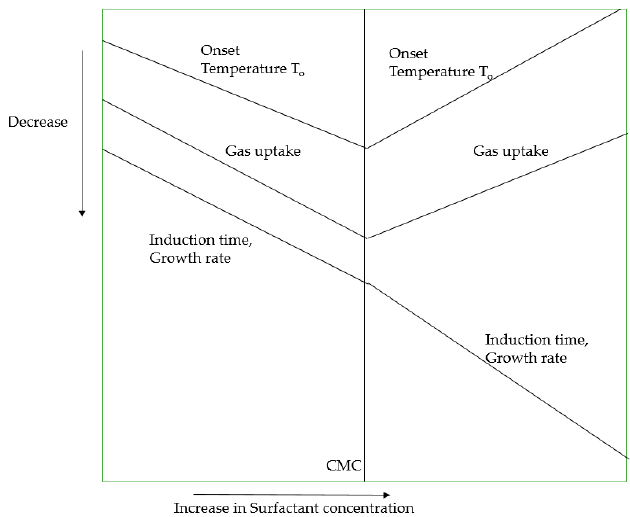
Figure 15. Summary of the trend observed in key properties including onset temperature, gas uptake